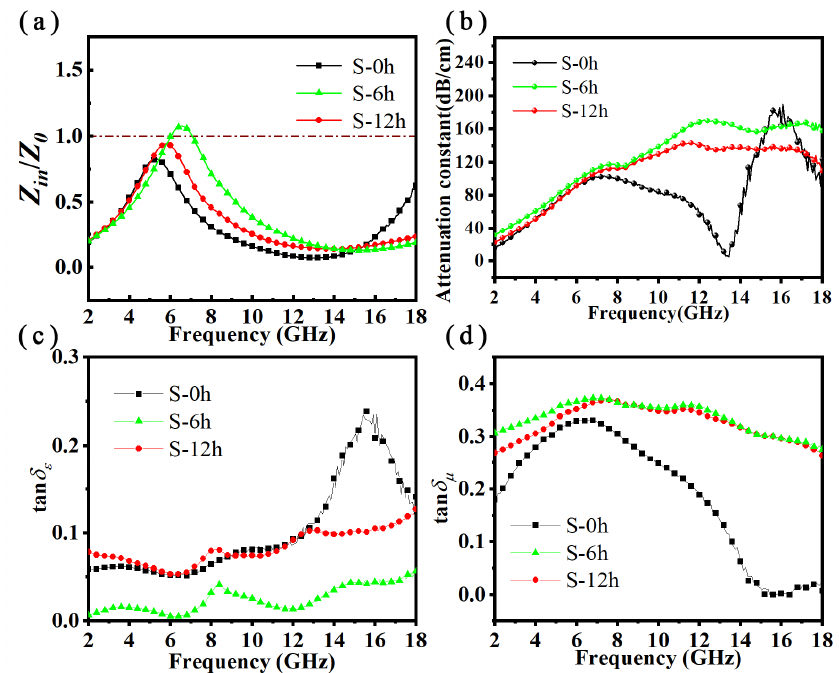
Figure 5. ( a ) Z in /Z 0 − f , ( b ) α − f , ( c ) tan δ ε − f , and ( d ) tan δ μ − f of three samples for NiCoMnSn alloy flakes.